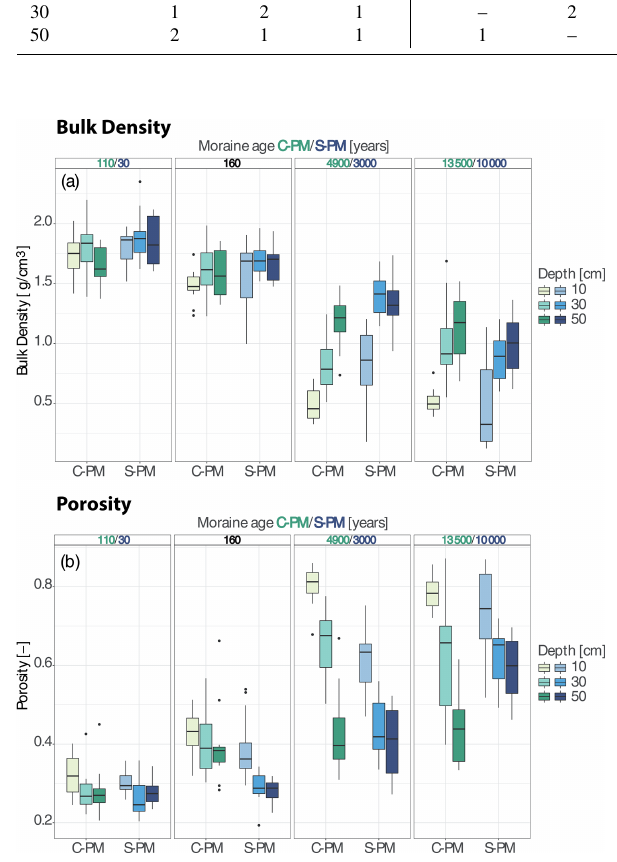
Figure 2. Development of bulk density and porosity at 10, 30, and 50cm depth over 10 millennia on silicate (S-PM, shown in blue color scale) and calcareous (C-PM, shown in green color scale) par- ent